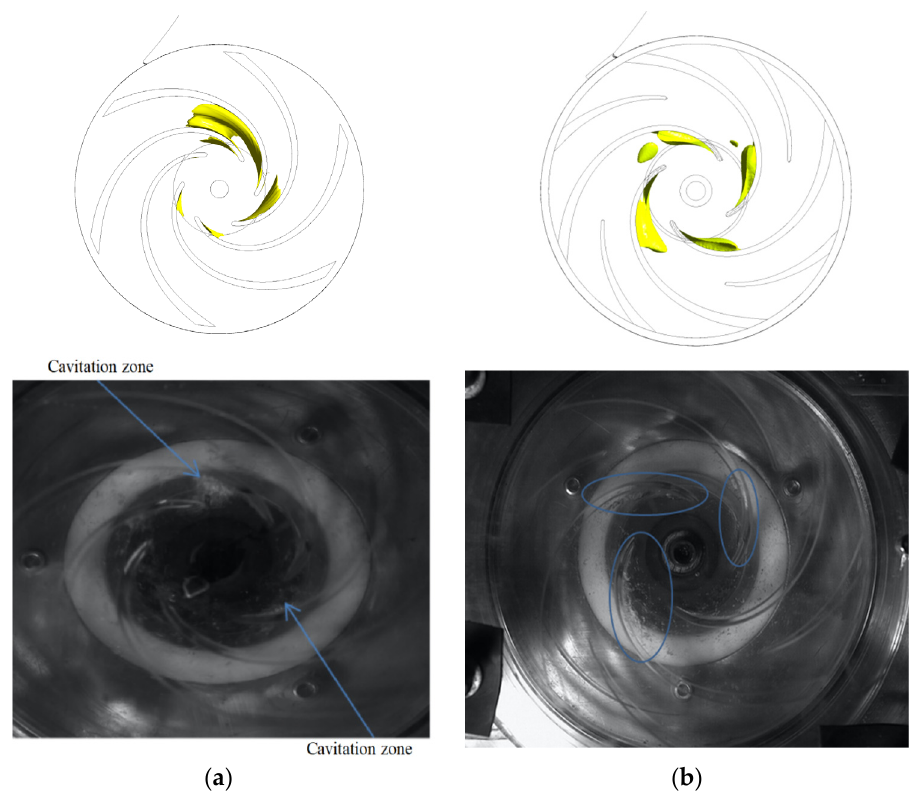
Figure 8. Cavitation zones in both cylindrical and splitter blades at σ = 0.058. ( a )Cylindrical blades; ( b )Splitter blades.